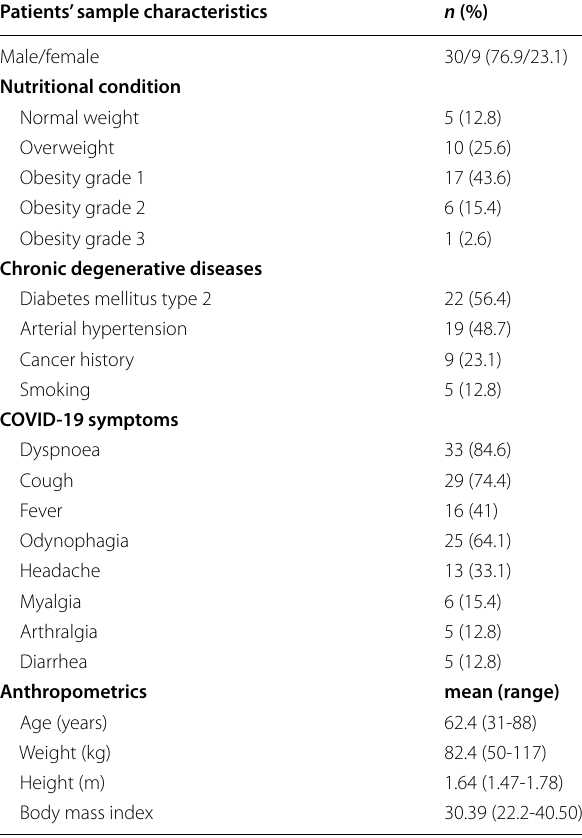
Table 1 COVID‑19 patients’ characteristics Patients’ sample